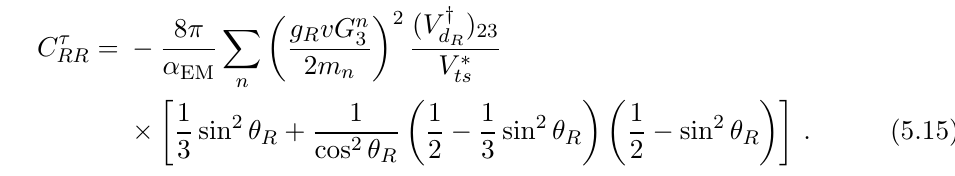
Figure 11 . Contour lines of R (cid:28) with the (cid:13)avor